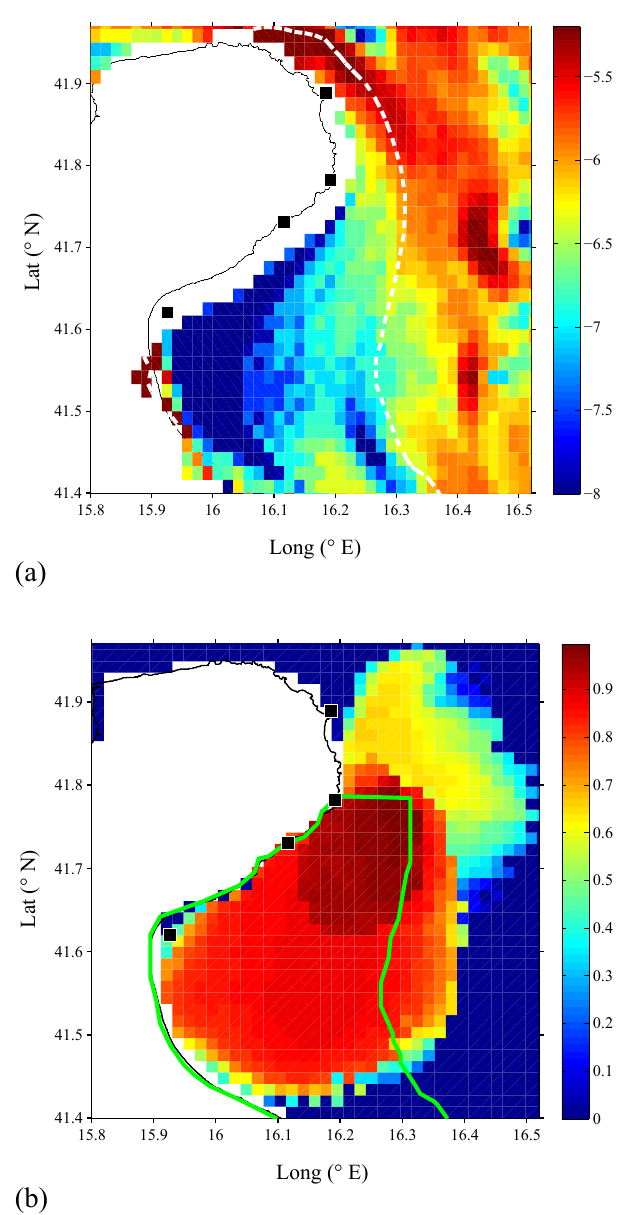
Figure 3. (a) The Gulf of Manfredonia with the four HF radar in- stallations denoted by black squares from north to south: Vieste, Pugnochiuso, Mattinatella, and Manfredonia, respectively. Colors indicate the logarithm of the bottom slope, and the dashed white line corresponds to the 25m isobath used to define the offshore bound- ary of the gulf. (b) The average HF radar radial coverage and the relative data density are shown during the period October 2013– May 2014. The boundaries of the Gulf of Manfredonia as defined in Sect. 3.4 are represented by the green line.